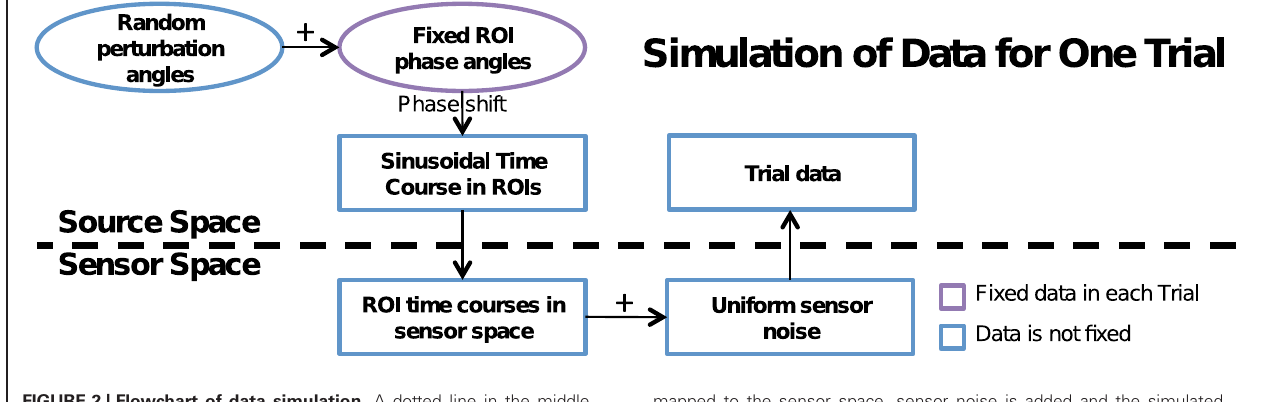
FIGURE 2 | Flowchart of data simulation. A dotted line in the middle separates source and sensor space computations. A random perturbation phase angle is added to the fixed phase angle at each ROI to induce a phase shift on the sinusoidal time course of that ROI. The time course is